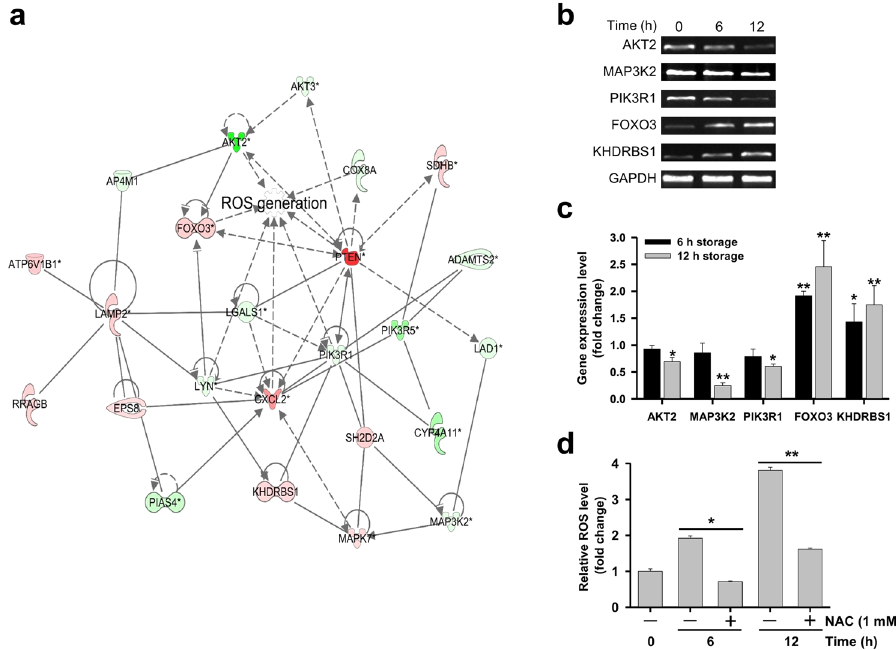
Figure 2. Changes in ROS-related gene expression and ROS generation in hBM-MSCs over time. ( a ) An ROS-related gene network was constructed algorithmically by IPA. Red and green areas indicate up- and downregulated genes, respectively. Differentially expressed genes were identified by microarray analysis without fold-change cut-off. ( b ) Semi-quantitative RT-PCR detection of ROS-related genes ( AKT2 , MAP3K2 , PIK3R1 , FOXO3 , and KHDRBS1 ) in hBM-MSCs after 6 or 12 h of storage in PBS. Glyceraldehyde 3-phosphate dehydrogenase ( GAPDH ) served as an internal control. Bands were cropped from Supplementary Fig. 2. ( c ) ROS-related gene expression in hBM-MSCs stored in PBS for 6 or 12 h, as determined by qPCR. Relative gene expression levels were normalized to that of GAPDH and compared to the level at 0 h (control). ( d ) Evaluation of intracellular ROS generation after 6 or 12 h using DCFH-DA. The intensity of non-oxidized DCFH-DA was used as a blank. Data represent mean ± SD of three independent experiments. * P < 0.05, ** P < 0.001 vs . 0 h